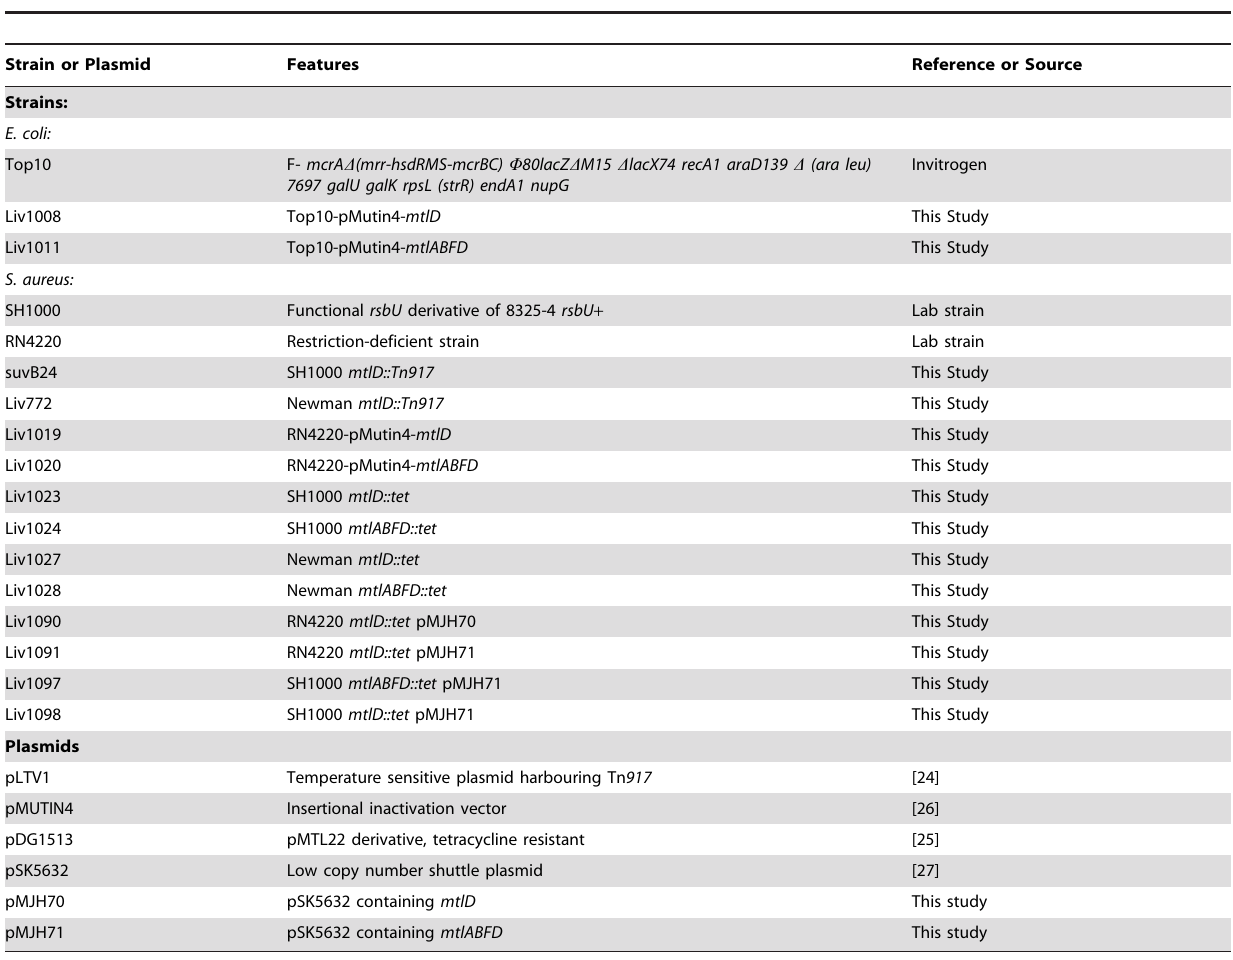
Table 1. Strains and plasmids used in the study.